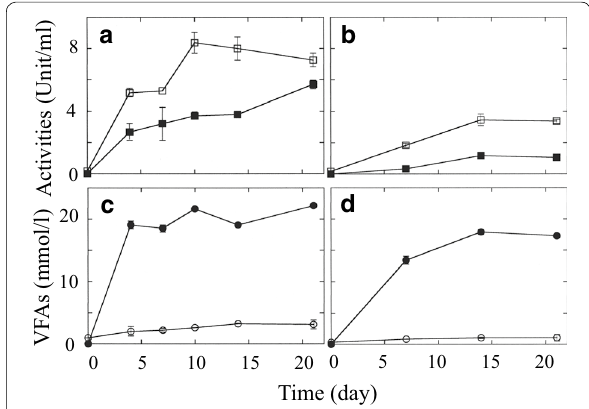
Fig. 3 Time courses of enzymatic activities and production of volatile fatty acids (VFAs) for strains H110 ( a , c ) and TB8 ( b , d ) with the freeze-dried dead biomass of F. oxysporum f. sp. spinaciae strain M2-1 as a substrate (1%, w/v) in the PY broth. open square, β,1-3-glucanase; filled square, chitosanase; open circle, acetate; filled circle, butyrate. Strain H110 produced small amounts of ethanol (< 1 mmol/l) and n -butanol (< 2 mmol/l). Strain TB8 produced none of alcohols. Error bars represent the standard